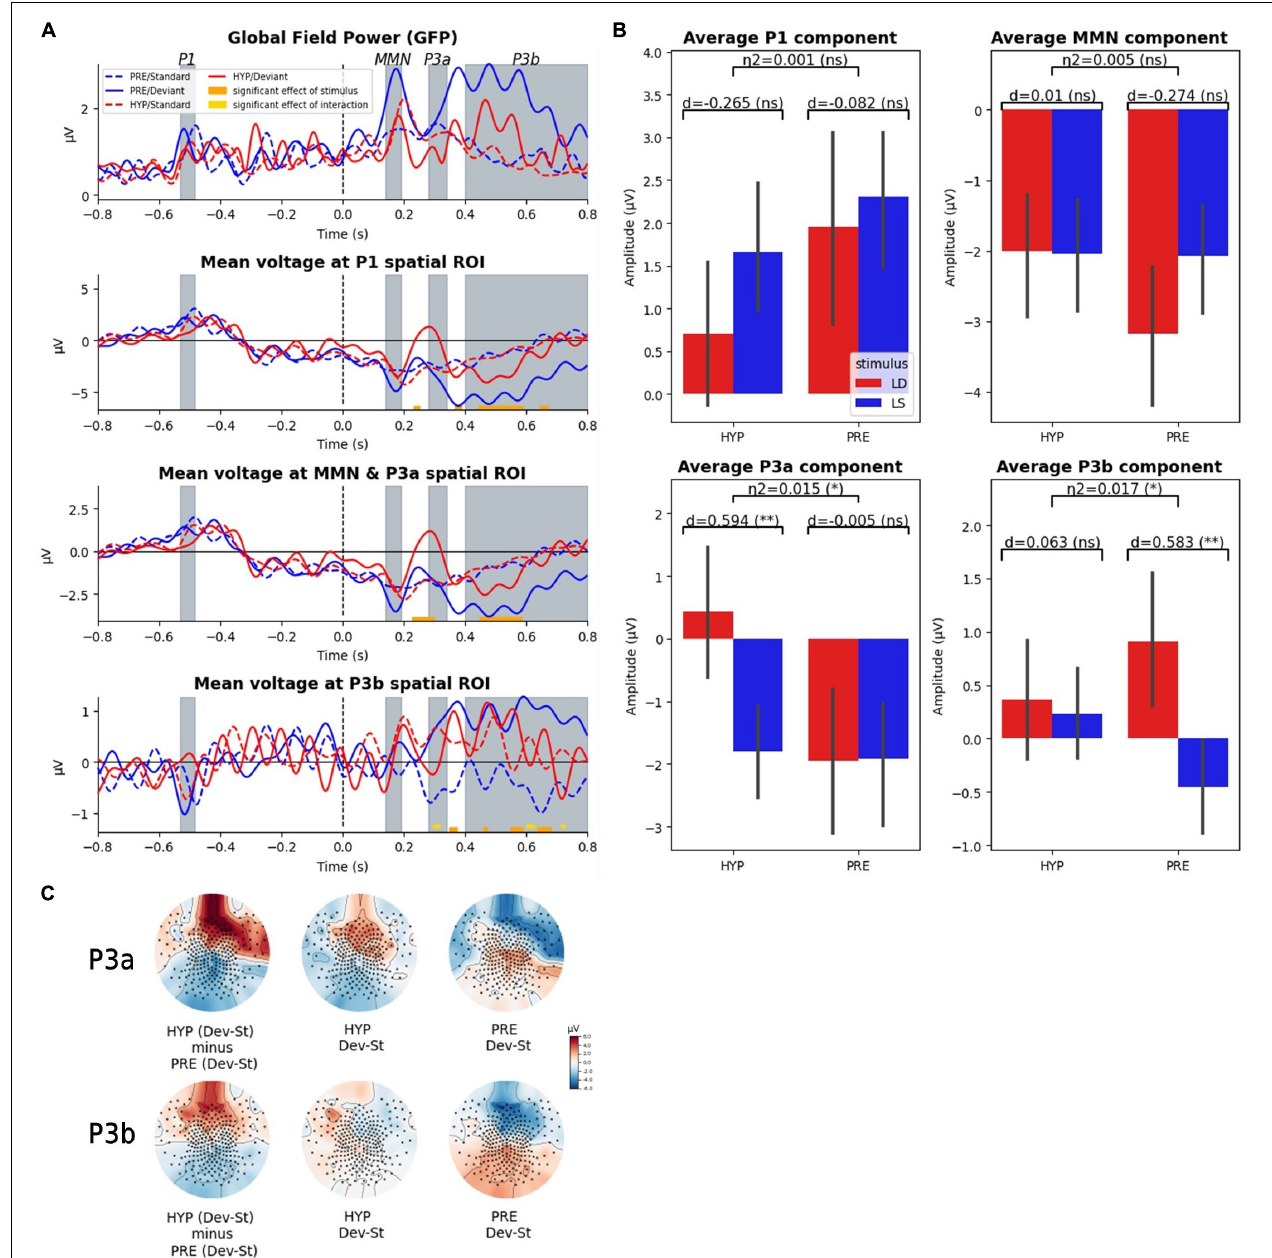
FIGURE 2 | Late ERP components (P3a, P3b) were affected by hypnotic deafness while early components were not (P1, MMN). Scalp evoked-related potentials (ERPs) during the auditory odd-ball paradigm, for baseline (PRE) and hypnotic deafness (HYP) conditions. (A) Time-series of the global field power (GFP) and the ERPs in three predefined spatial regions of interest. Doted lines show ERPs for standard stimuli and complete lines for deviant stimuli, for PRE condition (blue) and HYP condition (red). Bottom color lines show the time intervals that are statistically significant (FDR corrected) for the main effect of STIMULUS (orange) or the INTERACTION (gold) between STATE and STIMULUS. Gray-colored intervals correspond to the predefined time-windows of the P1, the MMN, the P3a, and the P3b components. (B) Average ERP components (P1, MMN, P3a, P3b) for standard (LS, blue) and deviant (LD, red) stimuli, in function of state (PRE and HYP). The plot shows the interaction effect of state × stimulus and the pairwise comparison of standard and deviant stimuli for each state. We found an increased P3a response (deviant minus standard) exclusively during HYP, and the presence of a significant P3b response (deviant minus standard) exclusively during PRE. (C) Topographical maps of the evoked odd-ball responses (deviant minus standard) in the predefined time-windows of the P3a and the P3b components for the PRE condition (right), the HYP condition (middle) and their subtraction (HYP minus PRE, left pannel). Note the absence of the canonical centro-posterior positivity during the P3b time-window in the HYP condition, but also the apparition of a centro-anterior positivity in the P3a time-window. ns: non-significant ( p -value > 0.05); ∗ FDR corrected p -value < 0.05; ∗∗ FDR corrected p -value < 0.01.